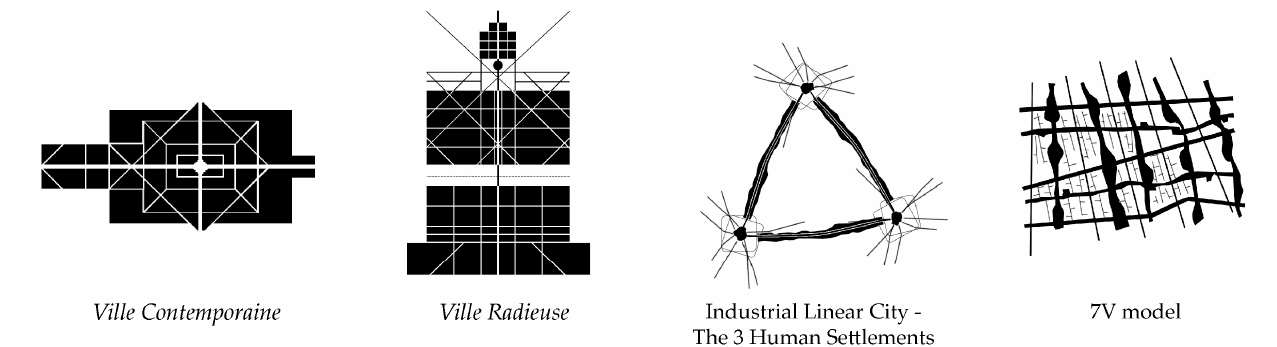
Figure 4. Le Corbusier ’ s urban models. Source: Authors.